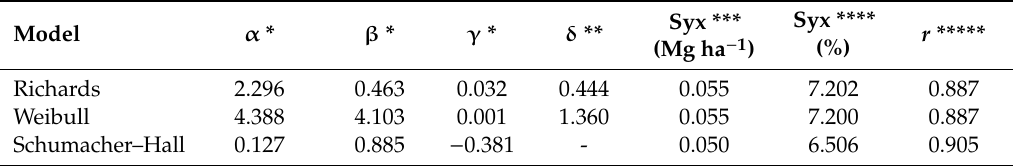
Table 10. Statistical parameters of the non-linear models obtained in the adjustment of the amount of magnesium in the eucalypt stands.